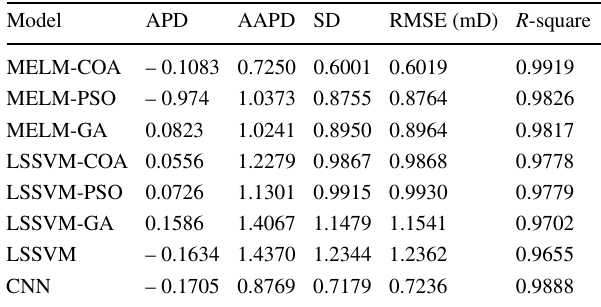
Table 7 Analyzing the results of different models for predicting the permeability from the testing data using different error indices and R 2